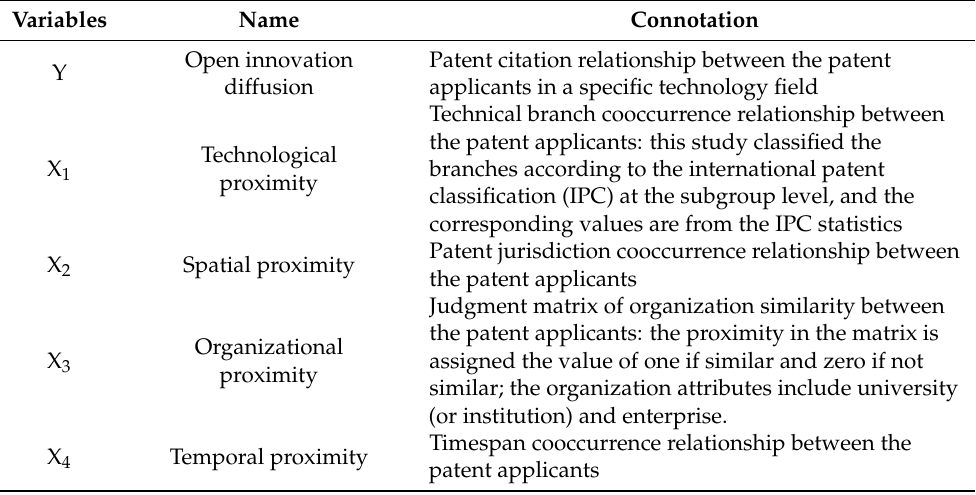
Table 2. Empirical variable